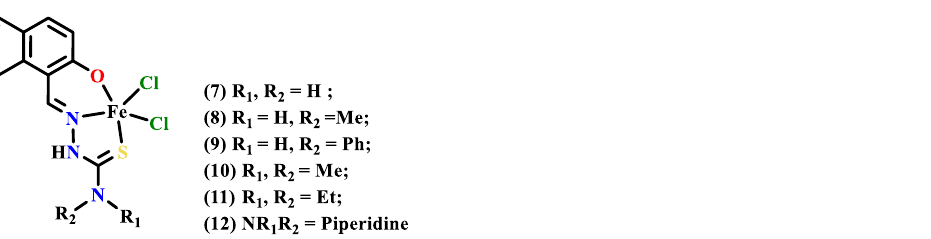
Figure 19. Six new Fe(III) complexes of 2-hydroxylnaphthylhydrazone with N -substituted thiourea side chains.